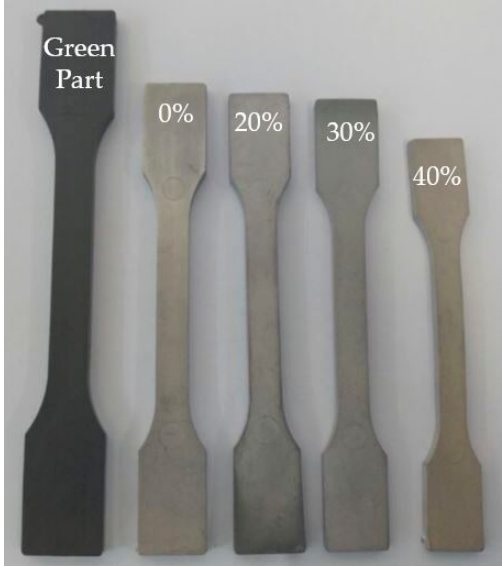
Figure 13. Optical photograph ( a ) and Scanning Electron Microscope (SEM) photograph ( b ) showing the cross-section of the sintered part with 30 vol % of polymethyl methacrylate (PMMA).